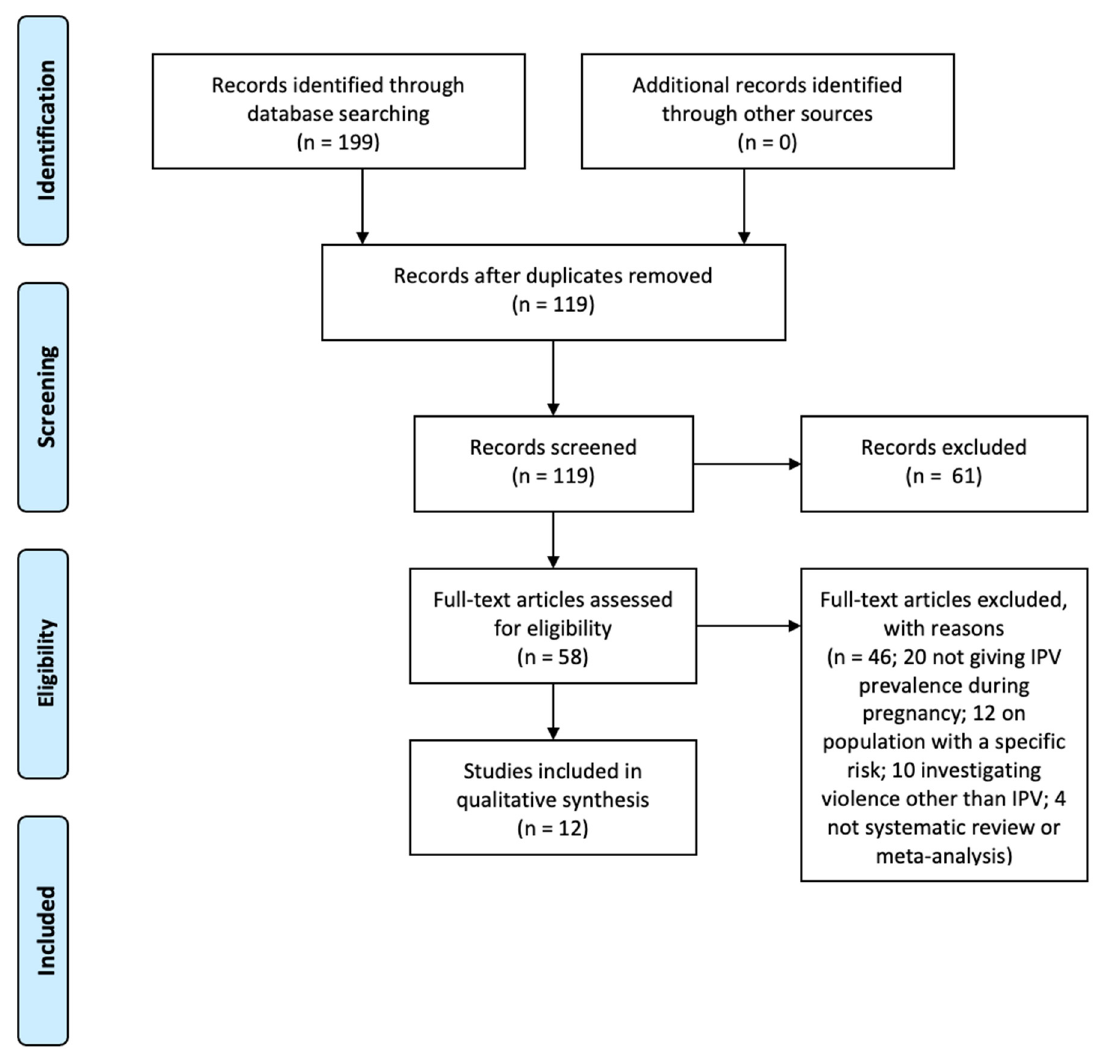
Figure 1. PRISMA flowchart of the study selection process. Table 2. Characteristics of the studies selected for the umbrella review of reviews of worldwide prevalence of IPV in pregnancy.